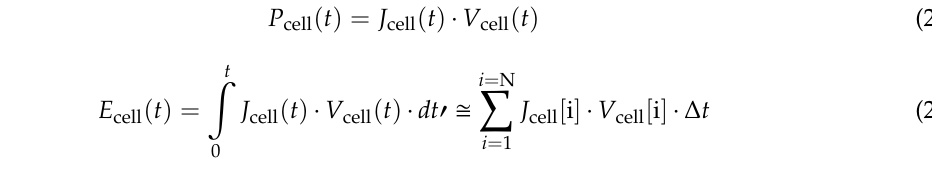
Figure 8. ( a ) Electric conversion efficiency ( η ) of the SOFC as a function of time from 0 to 1000 h. Degradation is considered in the anode ( η da ) layer alone, with drop of open circuit voltage ( η da+ Δ OCV ) and in both, anode and cathode layers, with drop of OCV ( η da/c+ Δ OCV ). ( b ) Electric power density ( P cell ) and energy yield ( E cell ) of non-degraded ( P ref , E ref ) and degraded SOFC ( P da/c+ Δ OCV , E da/c+ Δ OCV ) as a function of time from 0 to 10,000 h.